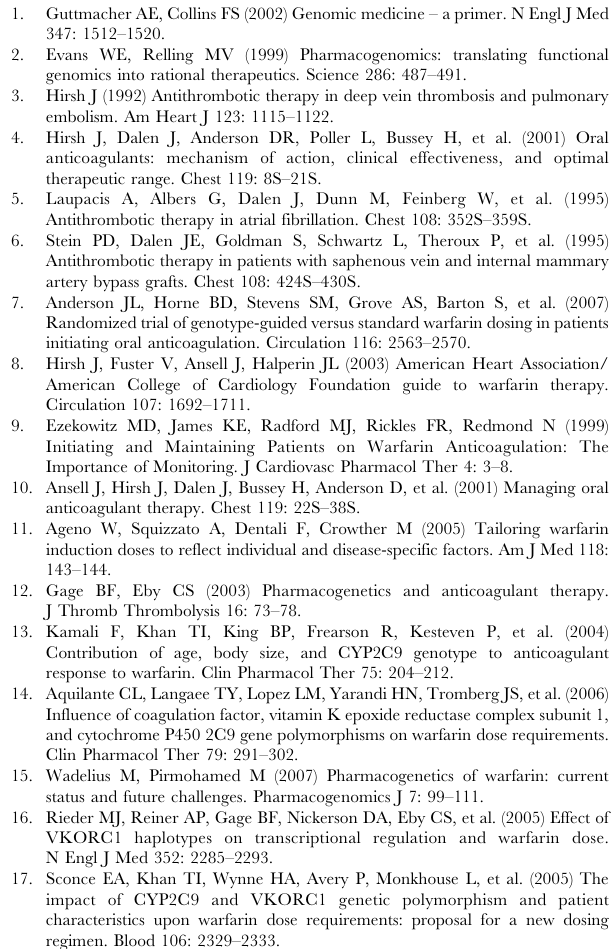
algorithm used patients on acenocoumarol treatment for deriving